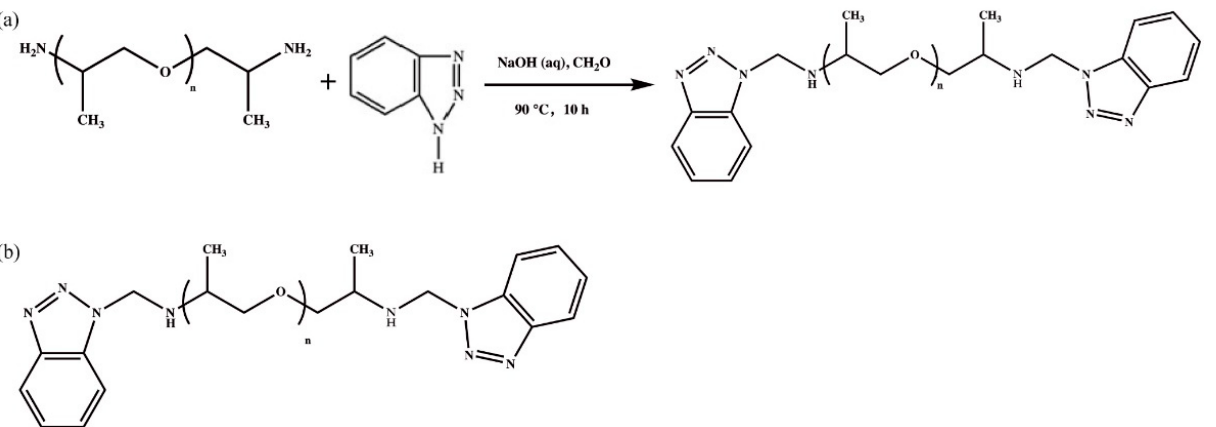
Figure 1. ( a ) The reaction formula. ( b ) The structural formula of the product.